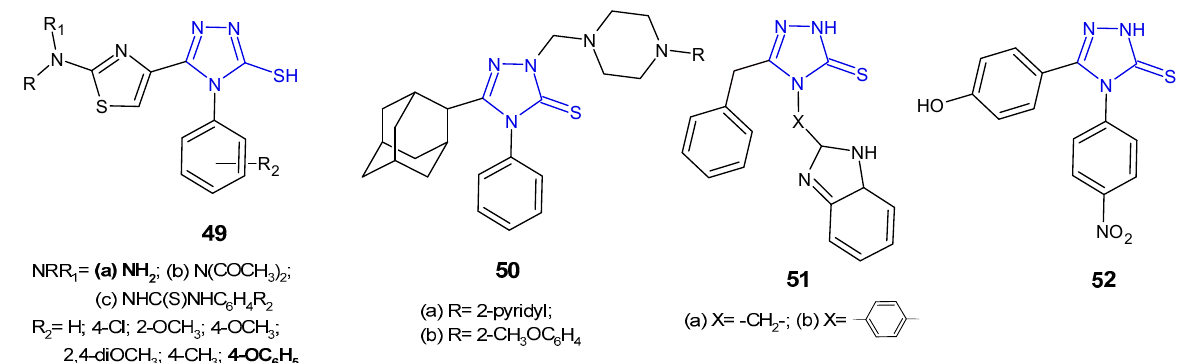
Figure 16. 1,2,4-triazole-3-thiones as antibacterial agents - continued. Al-Abdullah et al. (2014) synthesized Mannich bases of 5-(1-adamantyl)-4-substituted- 1,2,4-triazol-3-thione 50 (Figure 16) and screened their antibacterial activity against a panel of bacterial strains ( S. aureus ; B. subtilis ; M. luteus ; E. coli ; P. aeruginosa ). Among